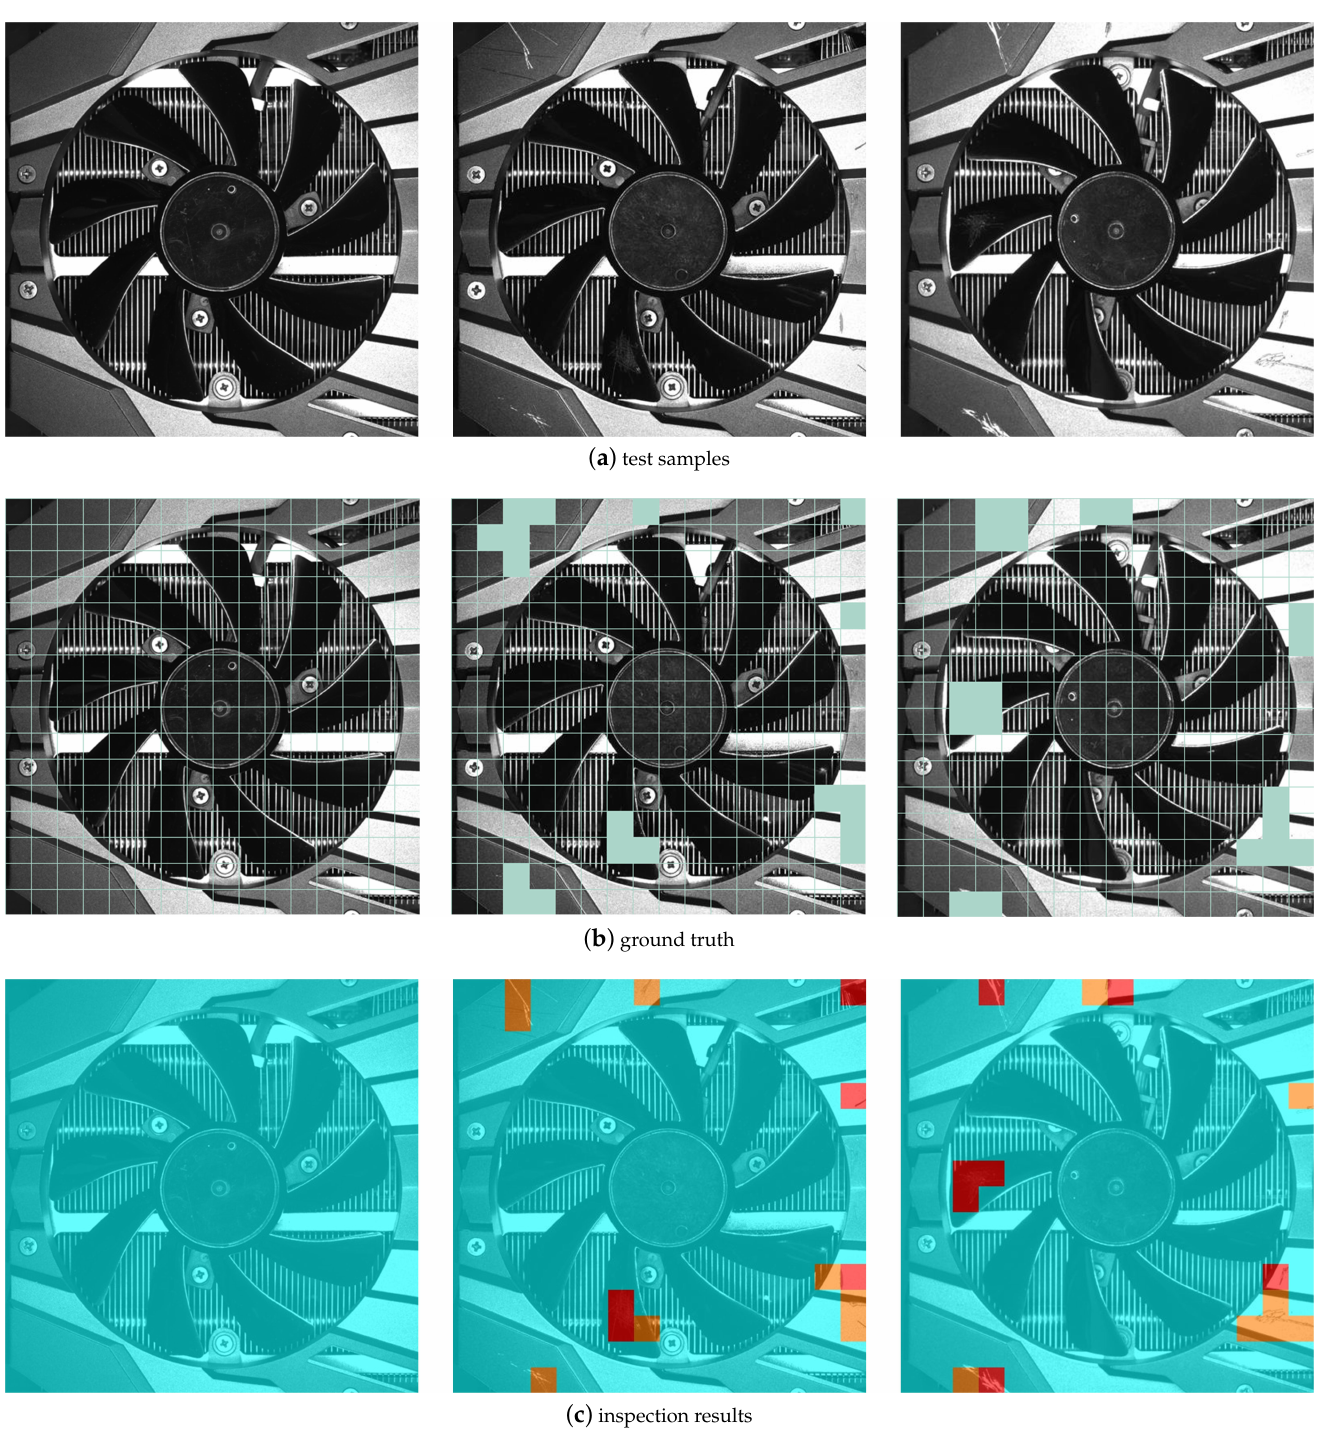
Figure 15. Examples of the input samples, their ground truth, and inspection results for the backplate of a display card: ( a ) input samples; ( b ) ground truth; ( c ) inspection